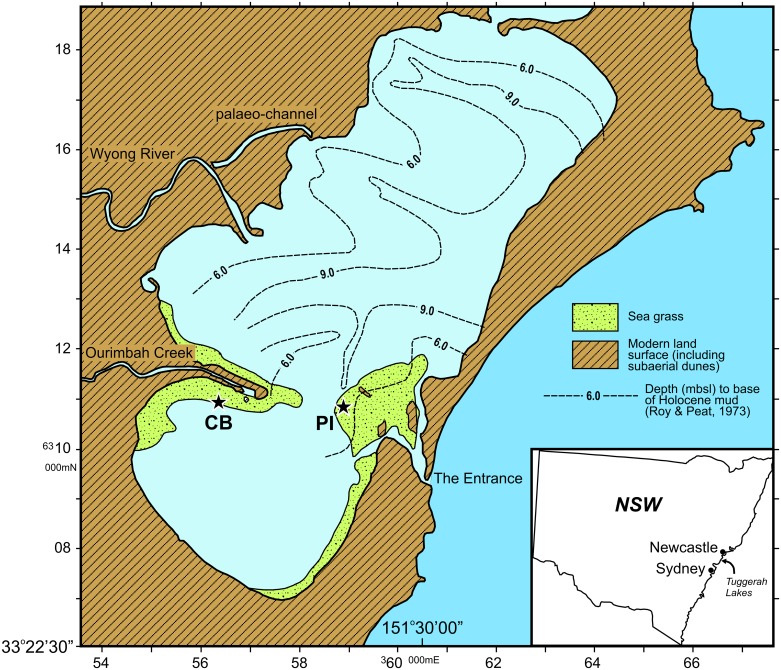
Map of Tuggerah Lake (NSW, Australia) showing the two study site locations (starred) where sediment cores were taken; Chittaway Bay (CB) and Pelican Island (PI).